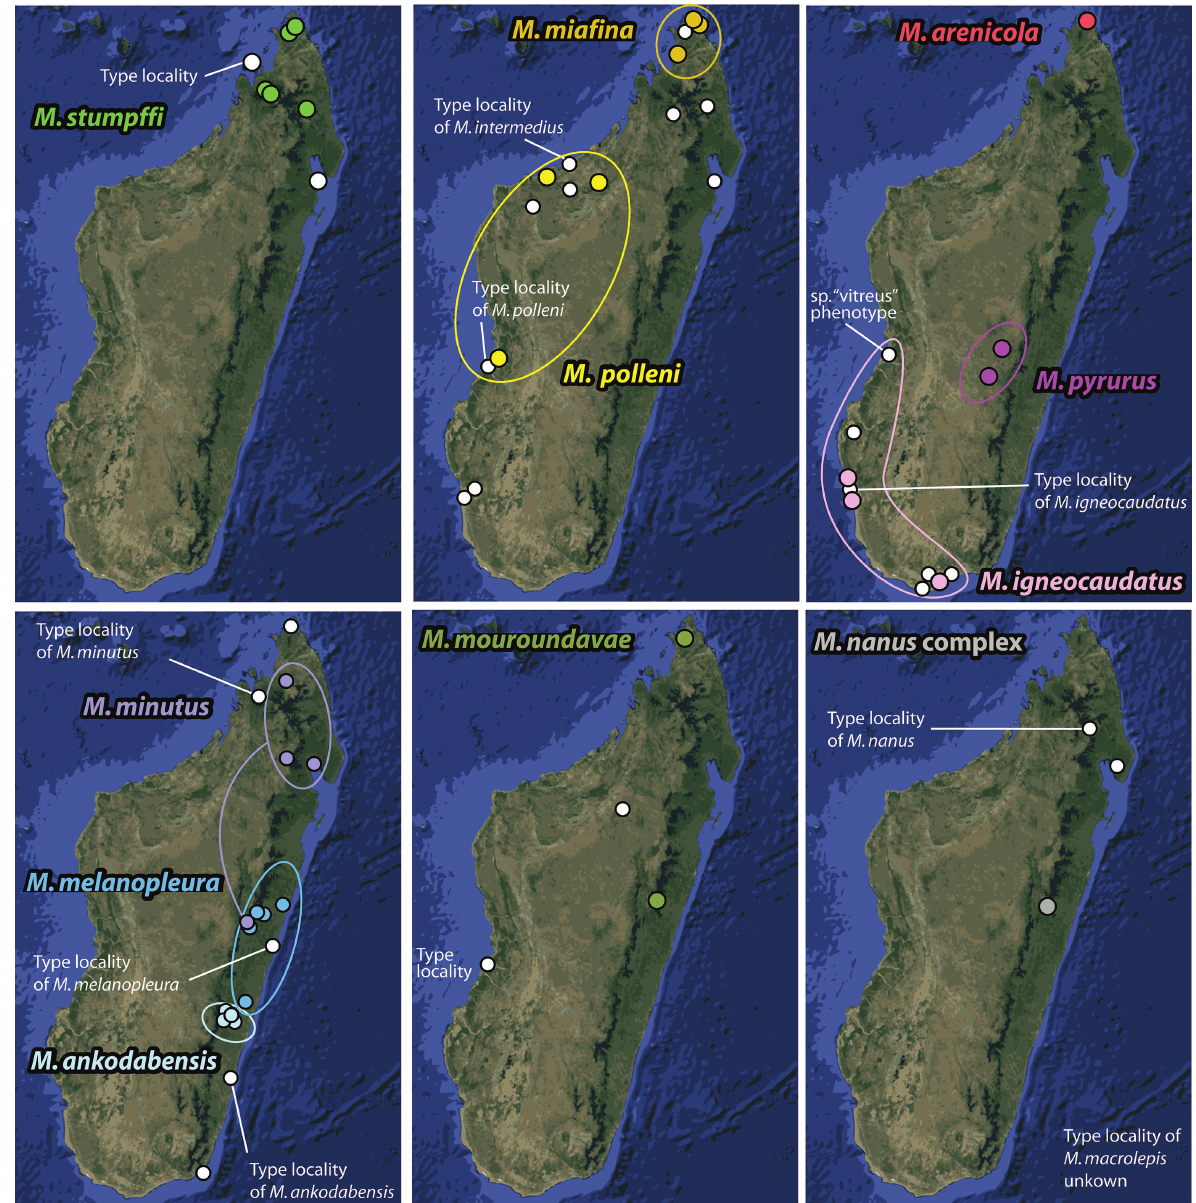
Figure 5. Distribution maps for Madascincus species. Colored dots are representing localities sampled in the molecular studies by Miralles and Vences (2013), whereas white dots are representing localities of specimens only identified by morphology, and/or type localities. For M. polleni , another locality has been added based on a recent paper from Rakotoarison et al. (2015), who have collected an additional specimen (ZCMV 14157) in Mitsinjo forest in north-western Madagascar (16°02’54.5”S, 45°47’24.1”E). The identity of this specimen is confirmed by both its morphological characteristics and its phylogenetic position inferred from a segment of the 16S rRNA gene (nested within the M. polleni clade, and closely related to the population of Ankarafanstika, Gen- Bank accession number KR025911). Note that for some species,especially M. mouroundavae , additional verified localities exist but these are here excluded for consistency because no samples were examined in the framework of the present